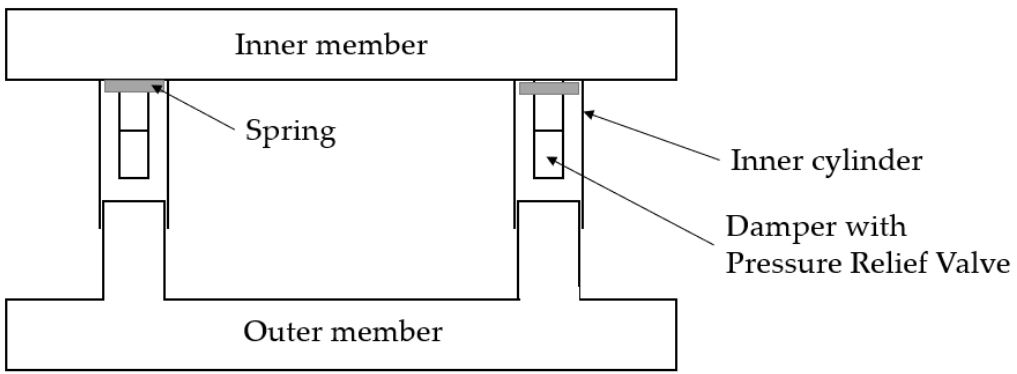
Figure 14. Block diagram of the rear underrun protection device with a pressure relief valve based damper.